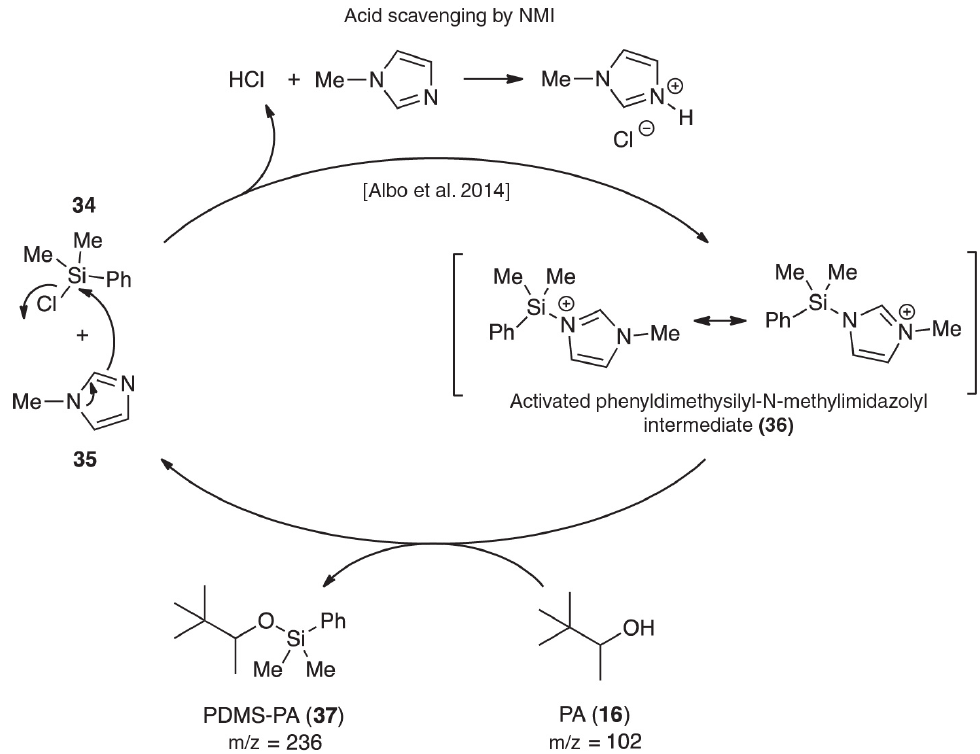
Figure 7: Proposed mechanism for the NMI-mediated phenyldimethylsilylation of PA ( 16 ) to furnish PDMS-PA ( 37 ). In this in situ activation of PDMSCl, NMI plays the dual role of (1) enhancing the reactivity of the silyl chloride through acti- vation and (2) sequestering the generated HCl from the reaction. The efficient silylation of PA using this method occurs in 30 min at ambient